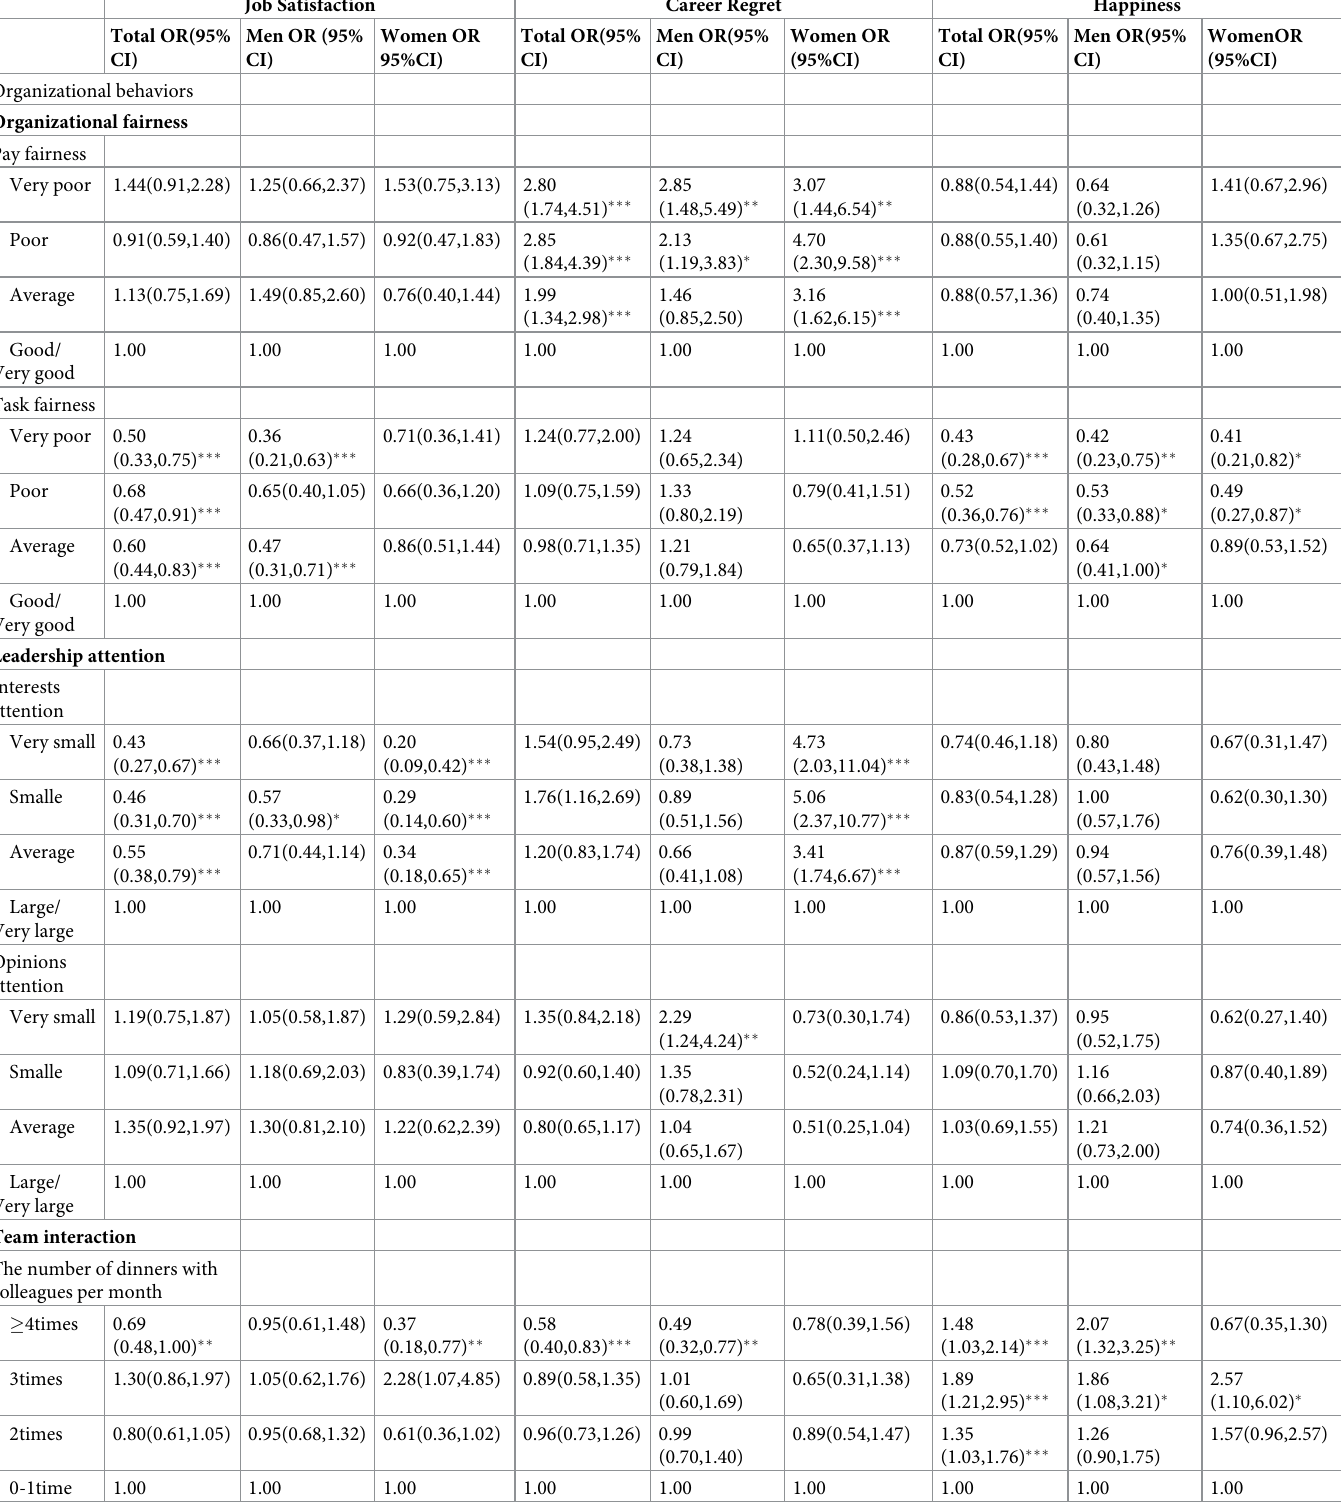
Table 4. Multivariable logistic regression results for association of organizational and patient behaviors-related effects for physicians